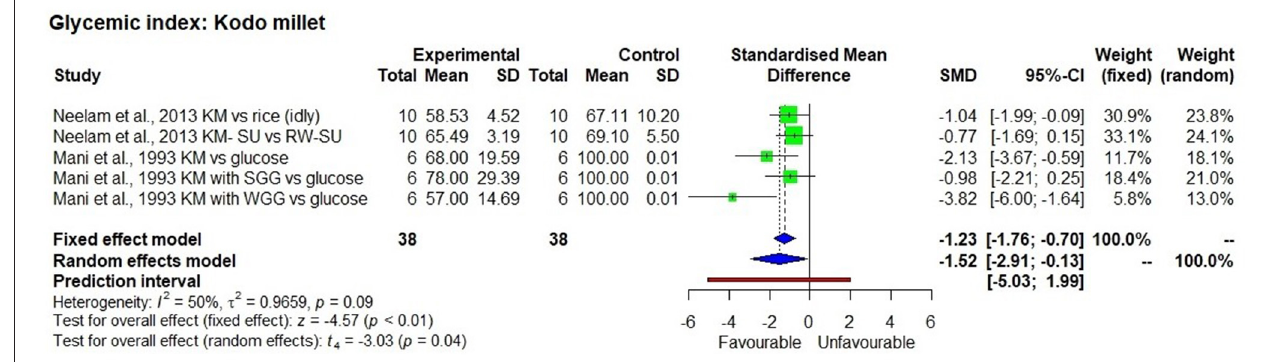
FIGURE 4 | The Glycaemic Index of a kodo millet diet compared to control samples.